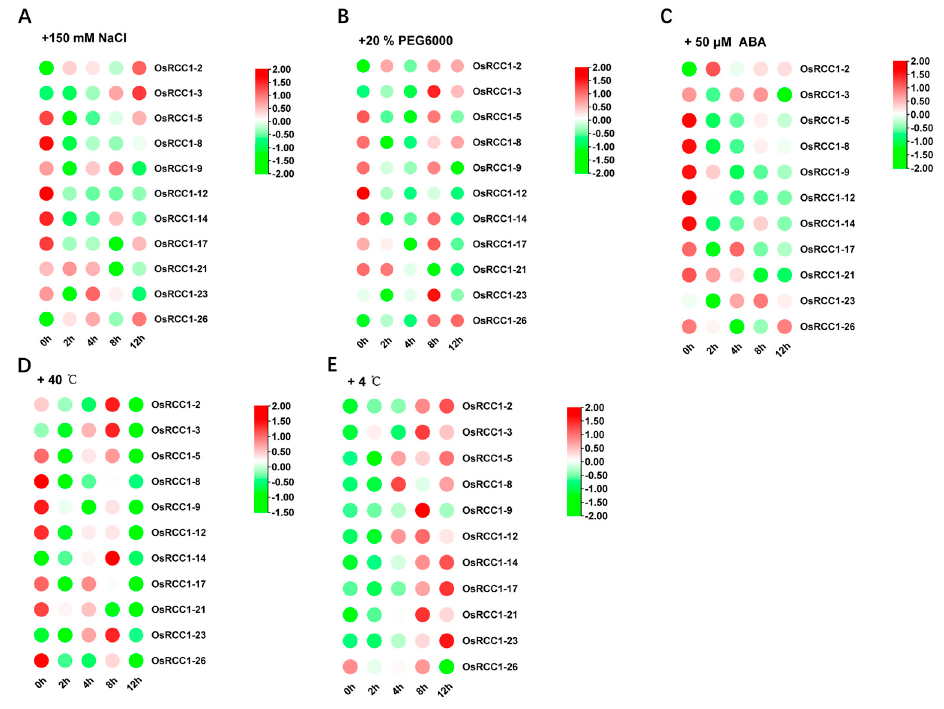
Figure 8. qRT-PCR based expression analysis of 11 OsRCC1s under abiotic stresses, viz salt ( A ), drought ( B ), ABA ( C ), heat ( D ) and cold ( E ) stresses. The red color shows the higher and the green color shows the lower expression levels in expression bar.